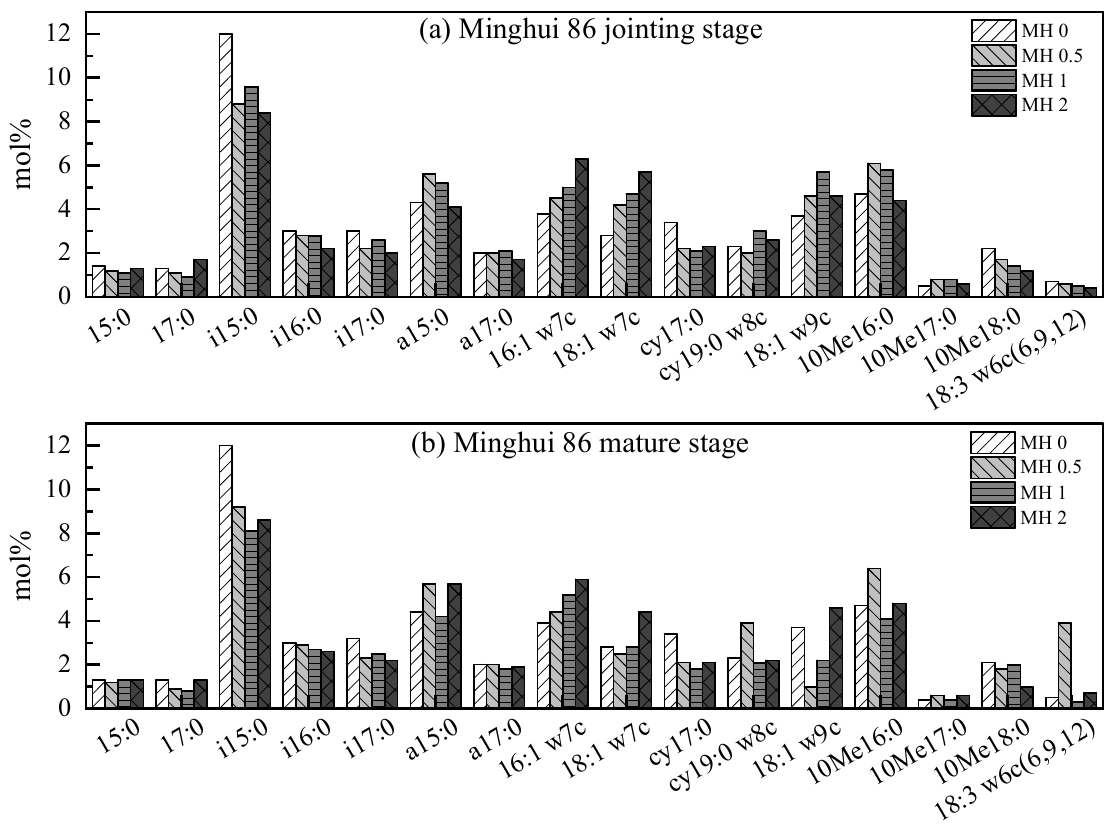
Figure 4. Distribution of PLFA with different concentrations of exogenous phosphorus added to MH: MH represents the MH; the numbers after MH represent the molar ratio of exogenous phosphorus to lead.